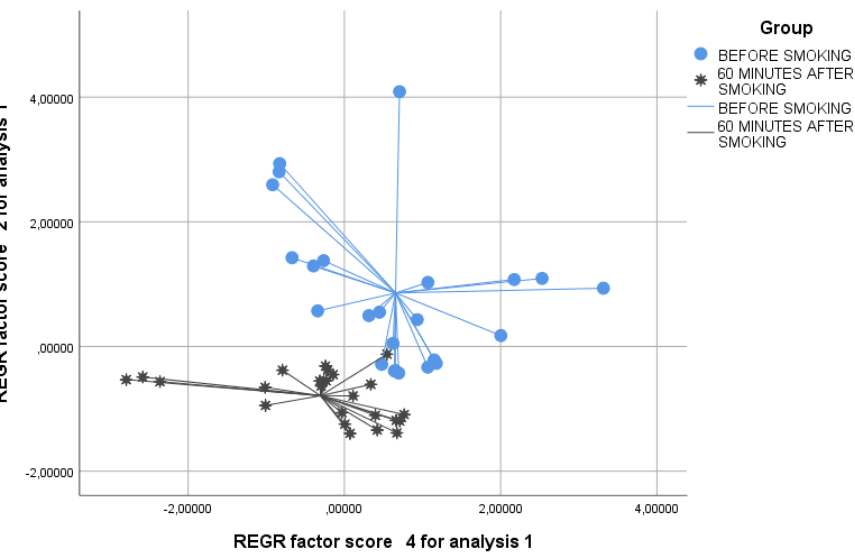
Figure 3. Two dimensional PCA plot showing the discrimination of breathprints before smoking (blue circles) and 30 min after smoking (green diamonds). REGR = regression.